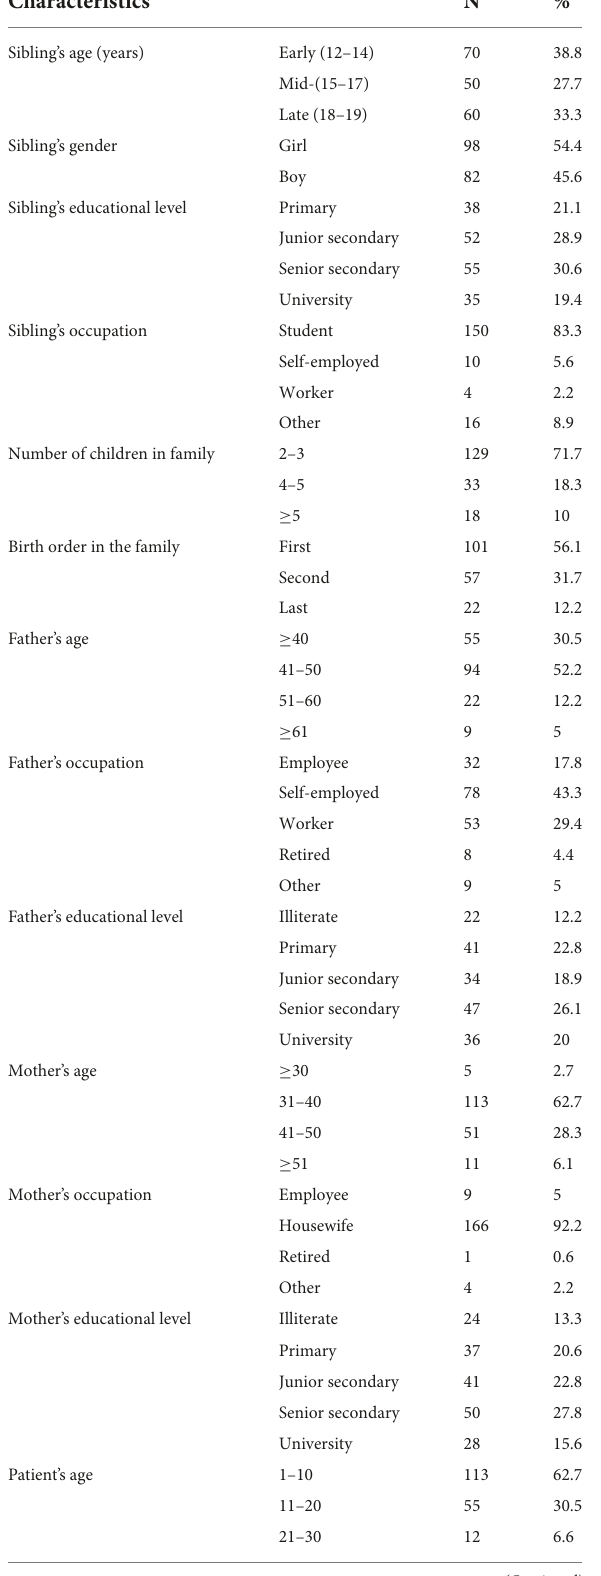
TABLE 1 Demographic and clinical characteristics of the participants.